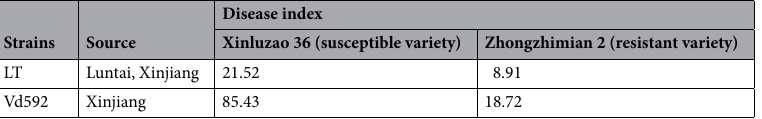
Table 1. Strains and disease index table.